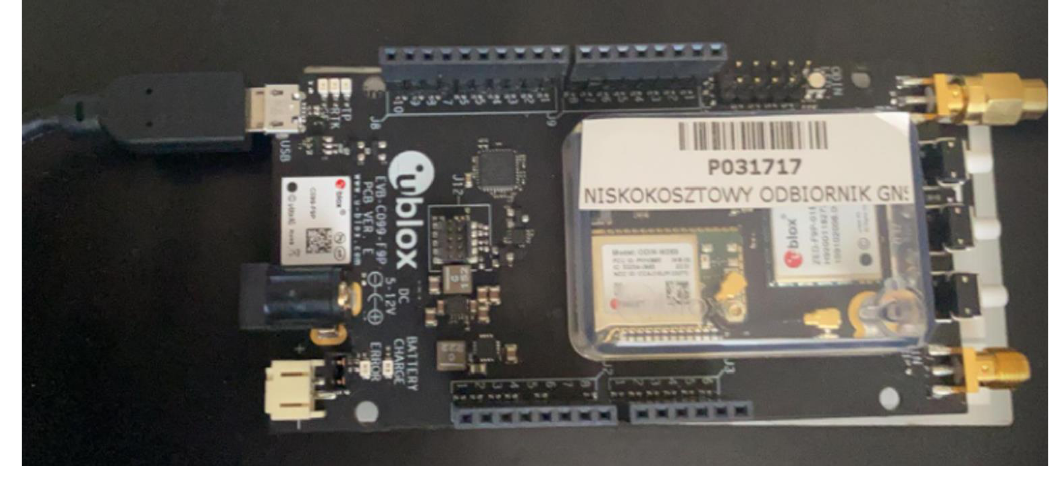
Figure 1. GNSS receiver used.